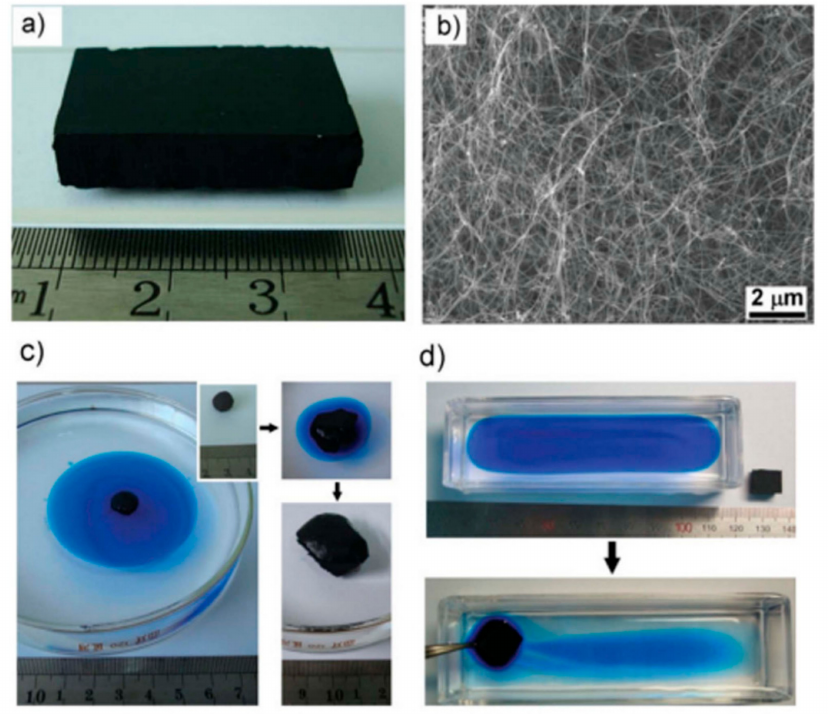
Figure 12. ( a ) A monolithic sponge with a size of 9.6 cm 3 ; ( b ) cross-sectional SEM image of the sponge demonstrating a porous morphology and overlapped CNTs. Images showing the absorption of ( c ) an oil dyed with Oil Blue and ( d ) an oil strip distributed on water by a sponge. Reproduced with permission from [210]. Copyright 2010 Wiley-VCH Verlag GmbH & Co. KGaA,